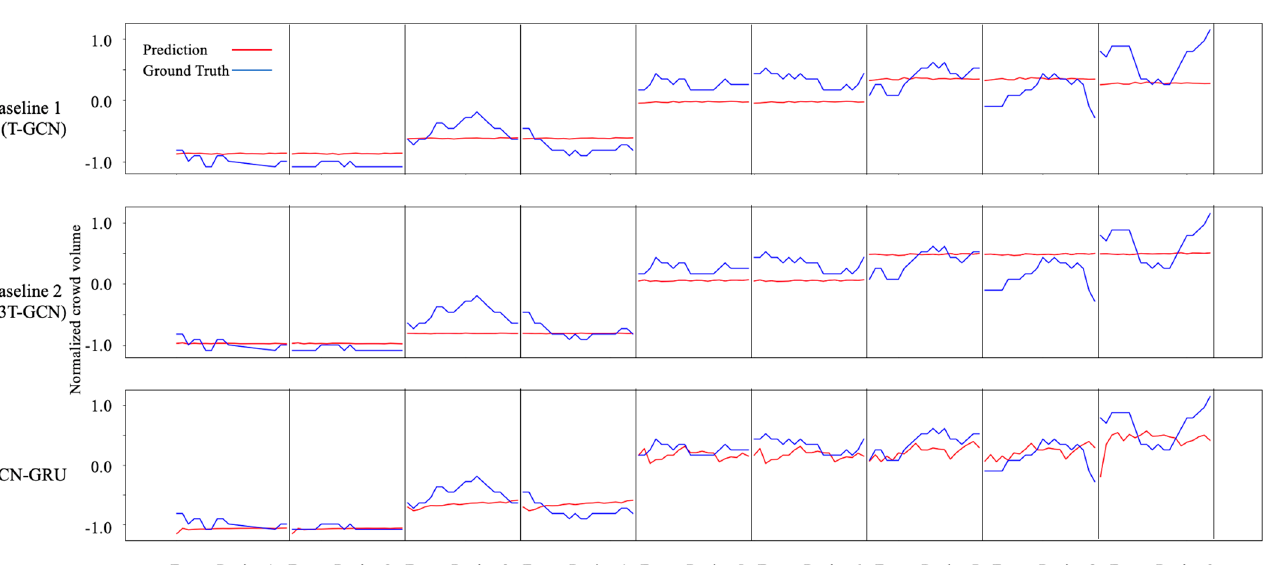
Figure 7. A sample sequence of the ground truth and predicted crowd flows at each of the nine egress regions at the Grand Central Station. The crowd volume, normalized to [ − 1, 1 ] is plotted on the Y -axis.